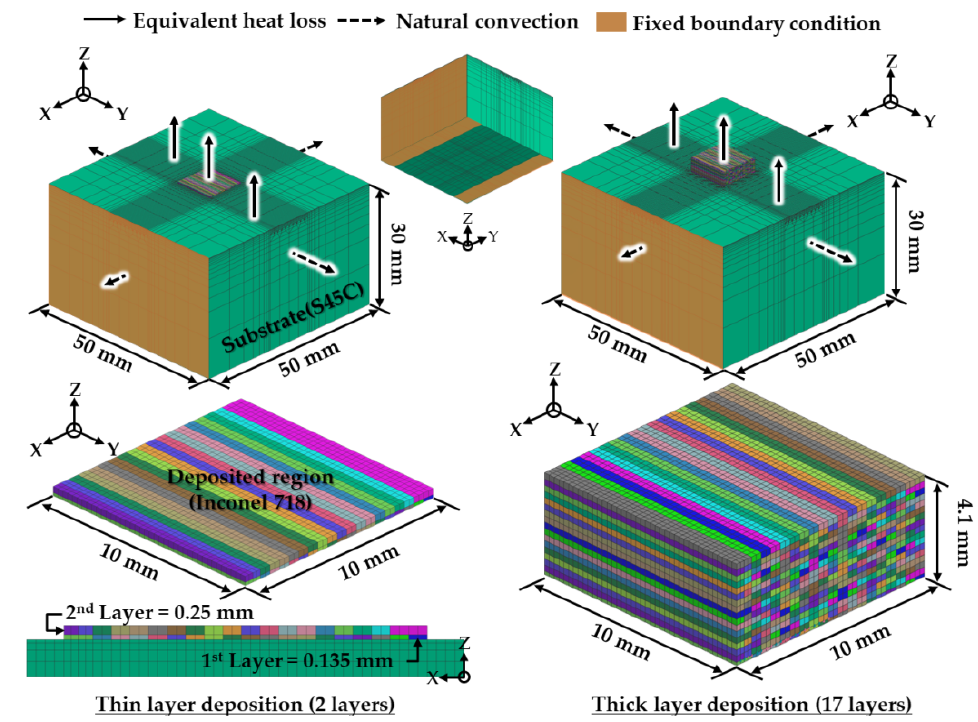
Figure 1. Models for finite element analyses (FEAs).